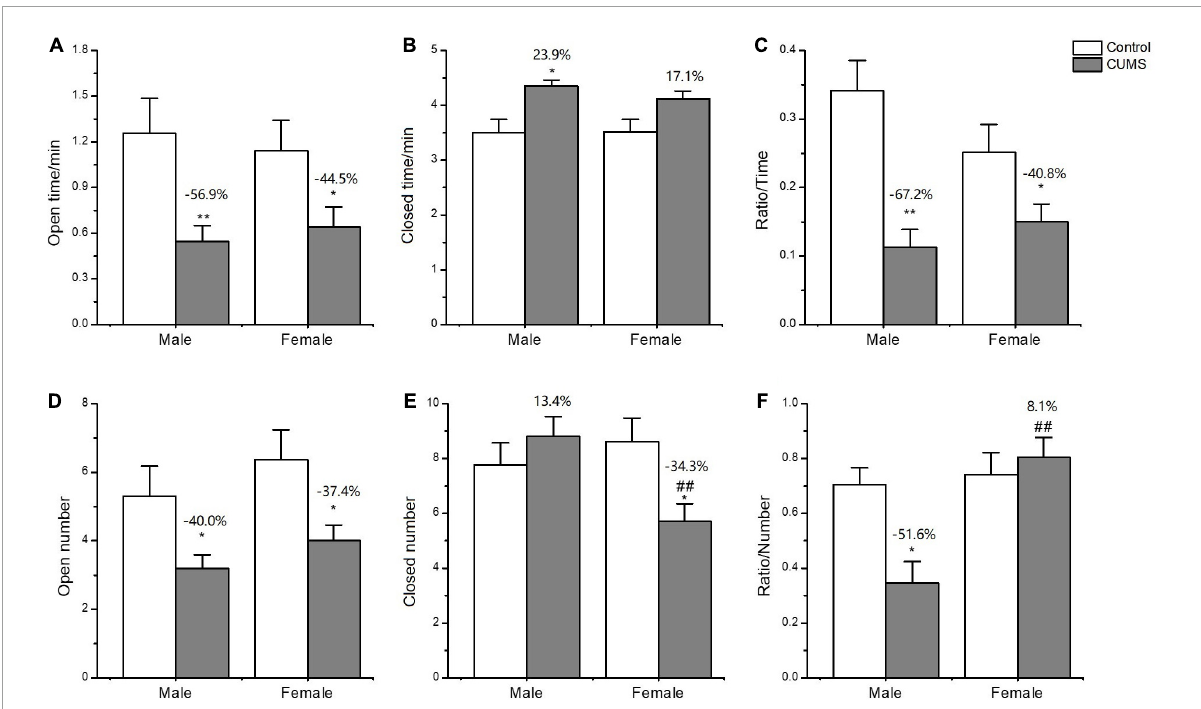
FIGURE5 Anxiety-like behavior induced by CUMS in EPM of male and female rats. (A,B) Time spent in the open arms and closed arms. (D,E) The number of entries into the open arms and closed arms. (C,F) The ratio of time spent on open/closed arms and entry numbers of open/closed arms. * p < 0.05, ** p < 0.01 vs. control with same sex, ## p < 0.01 vs. male stress group.